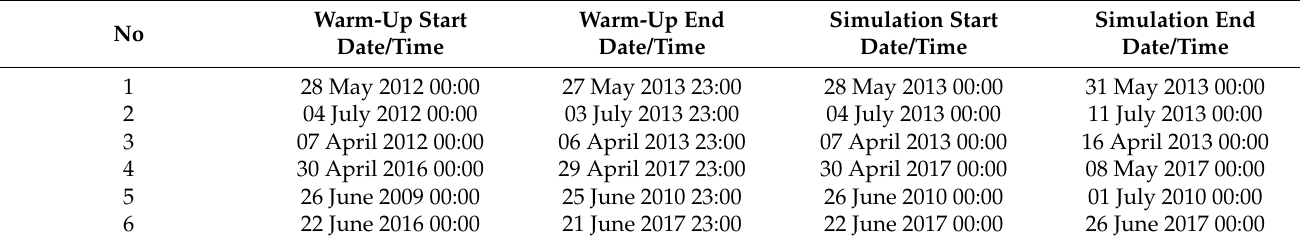
Table 7. Warm-up and simulation periods for each studied event, per sub-basin.